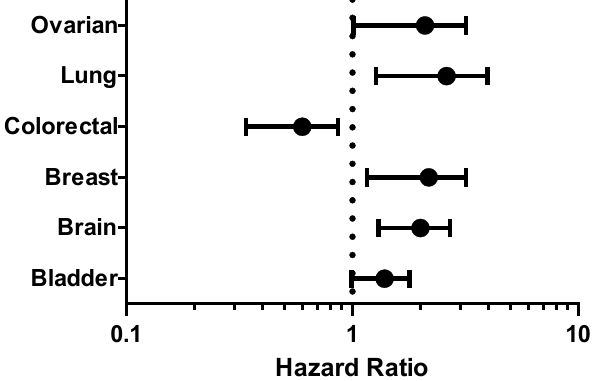
Figure 4. Meta-analysis of CHEK1 genes in different solid tumors. The statistically significant hazard ratio in various types of solid tumors was identified from the PrognoScan database in Table 2 and expressed as the forest plot. The analysis of the survival curve was identified as the threshold of a cox p -value < 0.05.